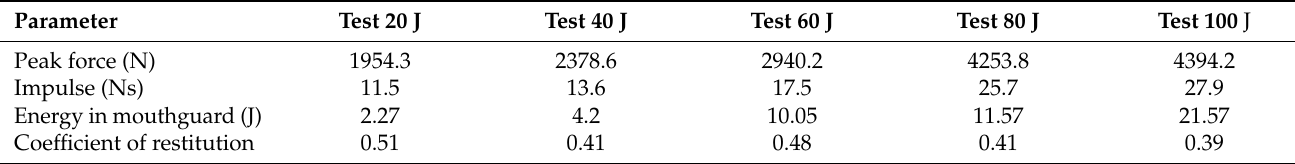
Table 5. Overview of the obtained maximum force, impulse and energy depending on the impact energy for the mouthguard.